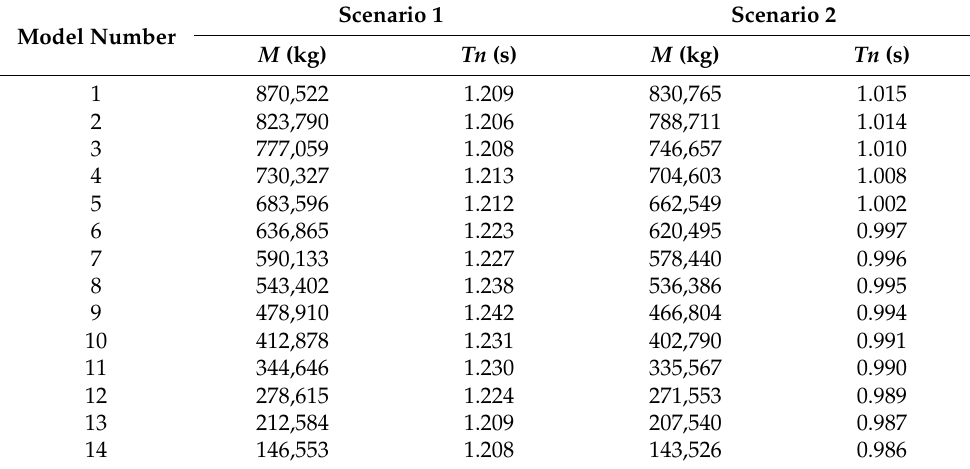
Table 2. PSW masses and natural